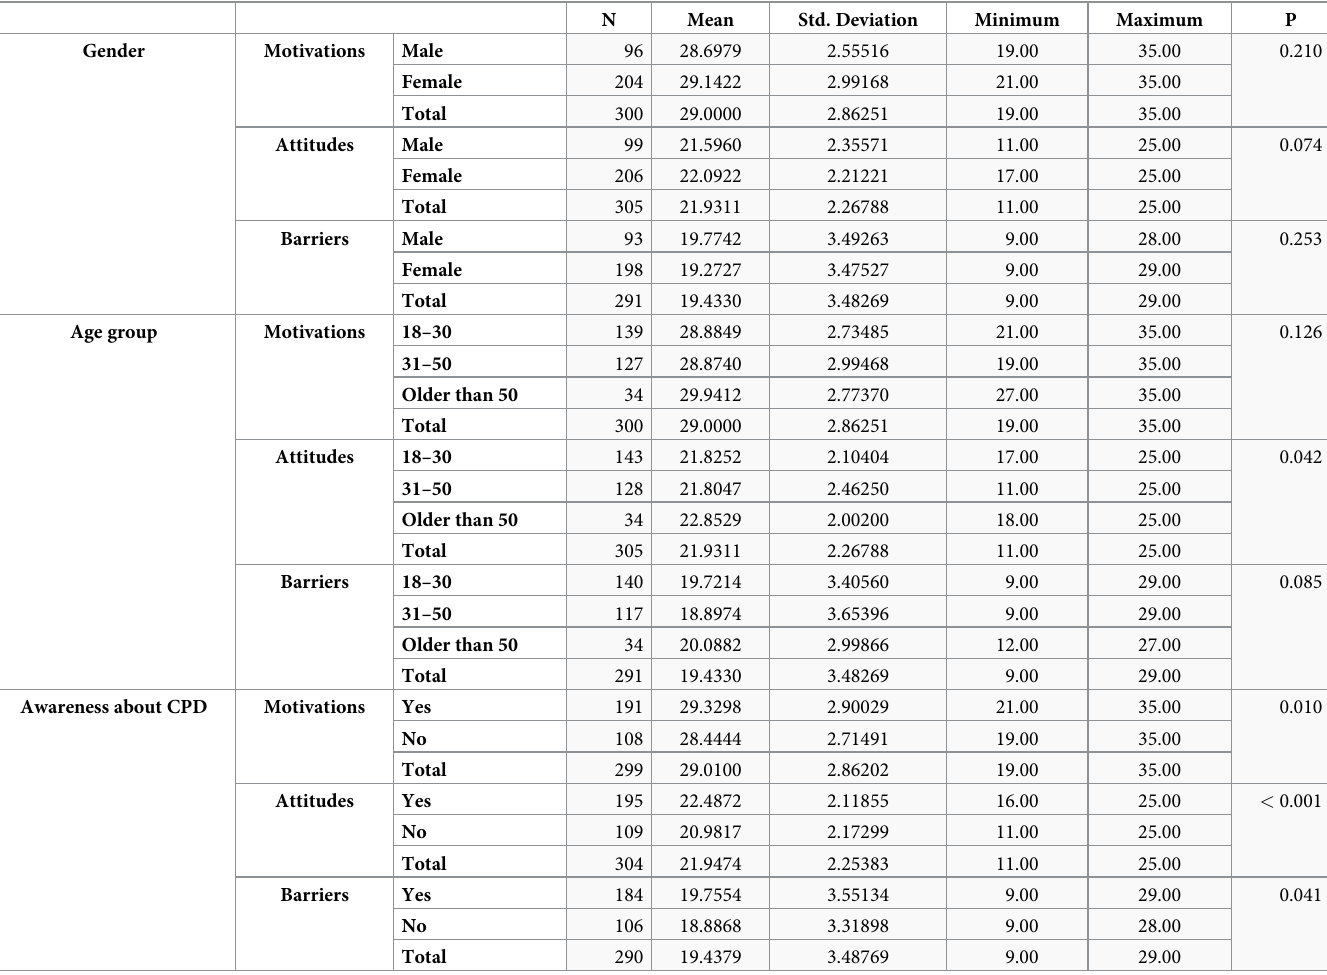
Table 4. Comparison of means for motivation, attitudes, and barriers based on gender, age groups, and awareness about